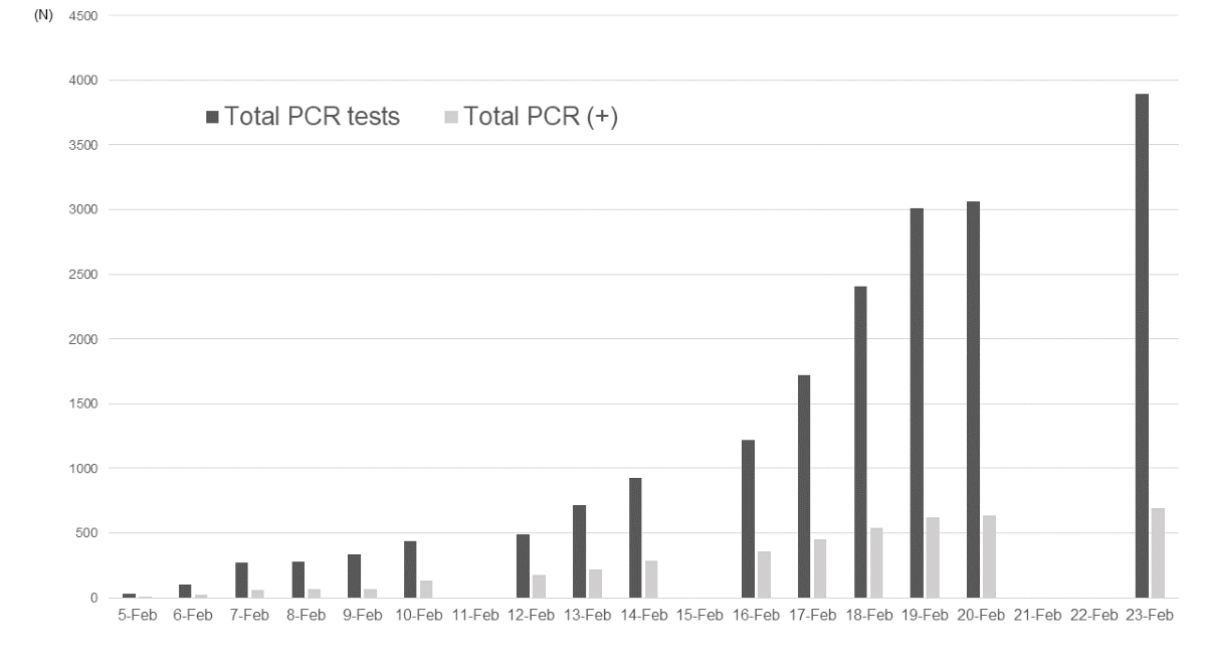
Figure 1. The total number of reverse transcription–polymerase chain reaction (RT-PCR) tests and positive